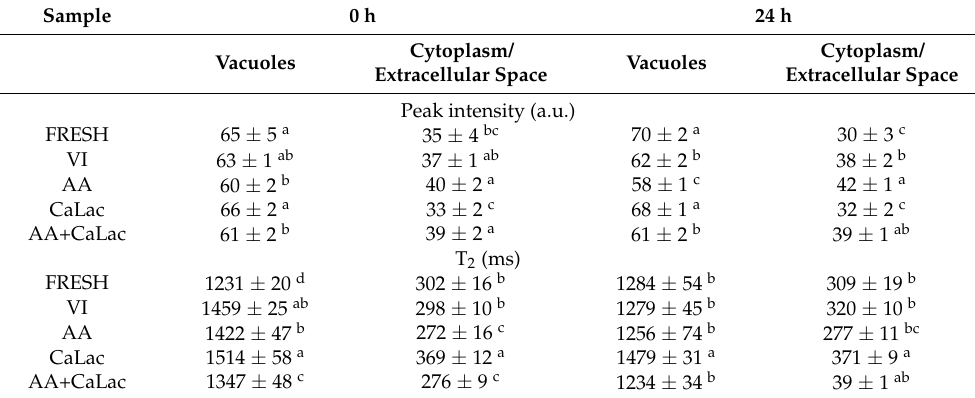
Table 5. Peak intensity and relaxation times (T2) of different cell compartments in fresh and vacuum- impregnated samples immediately after the vacuum treatment (VI) treatment and after 24 h storage. Sample 0 h 24 h Cytoplasm/ Cytoplasm/ Vacuoles Vacuoles Extracellular Extracellular Space